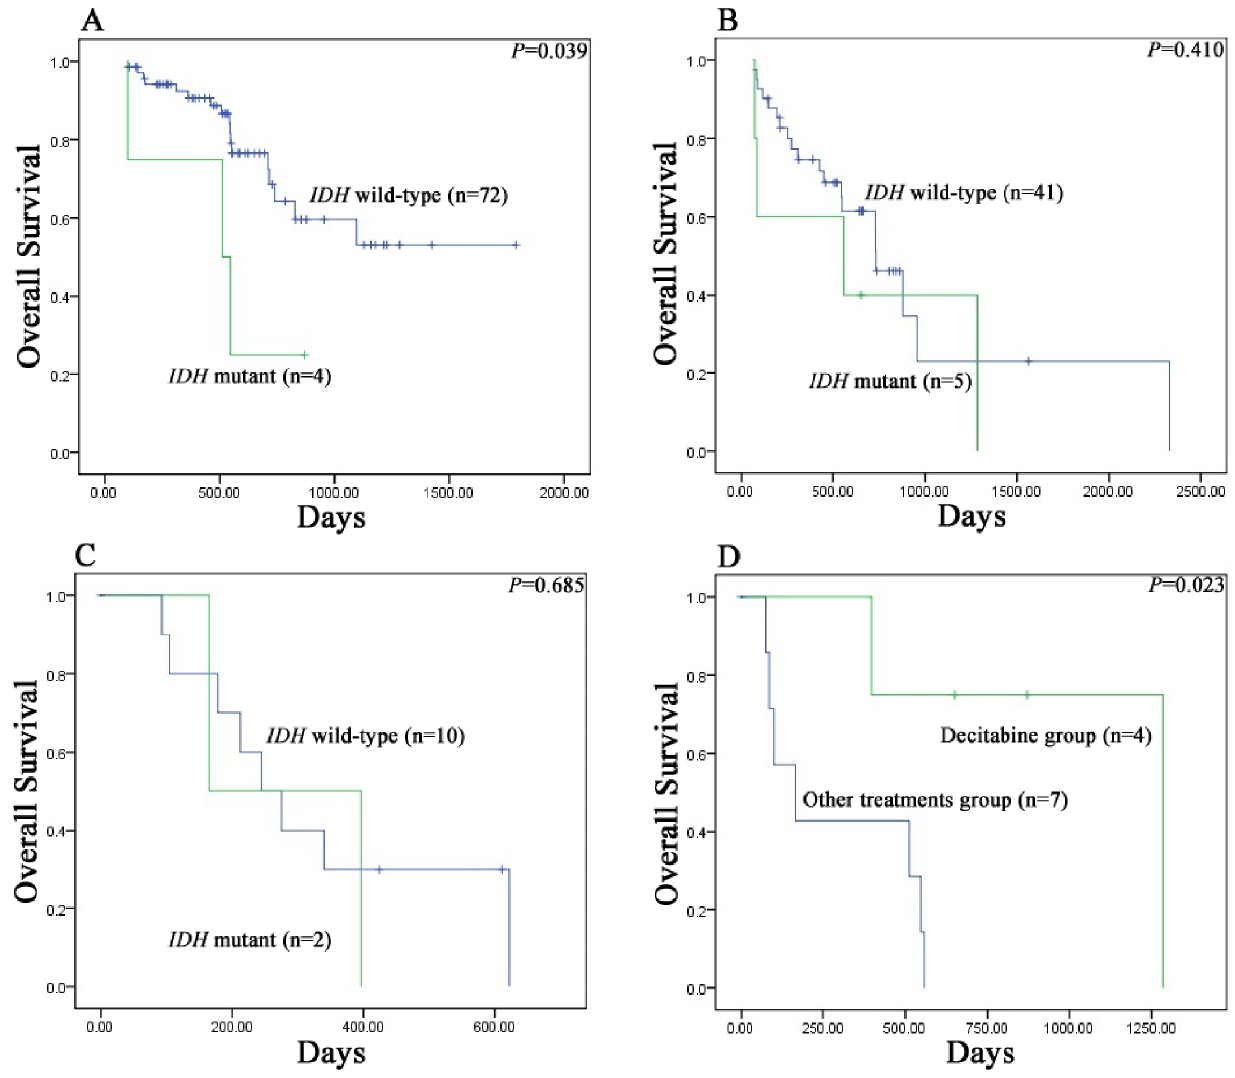
Figure 3. Kaplan–Meier survival curves for overall survival of MDS patients. (A) Overall survival of MDS patients in the intermediate-1 risk group of IPSS. (B) Overall survival of MDS patients in the intermediate-2 risk group of IPSS. (C) Overall survival of MDS patients in the high risk group of IPSS. (D) Kaplan–Meier survival of IDH mutant patients with decitabine chemotherapy compared with other treatments.